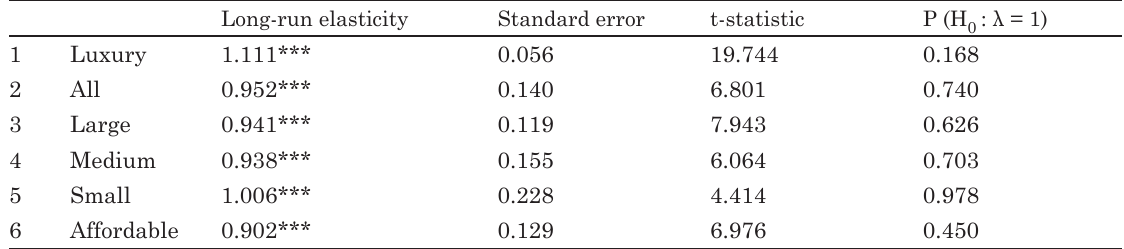
Table 2. Long-run elasticity of house prices in response to non-housing prices of goods and services Long-run